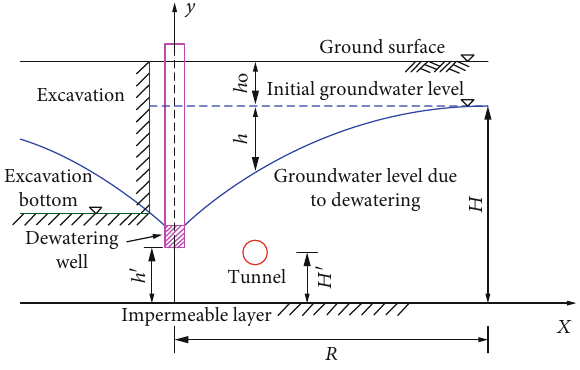
Figure 1: Schematic of dewatering during excavation.